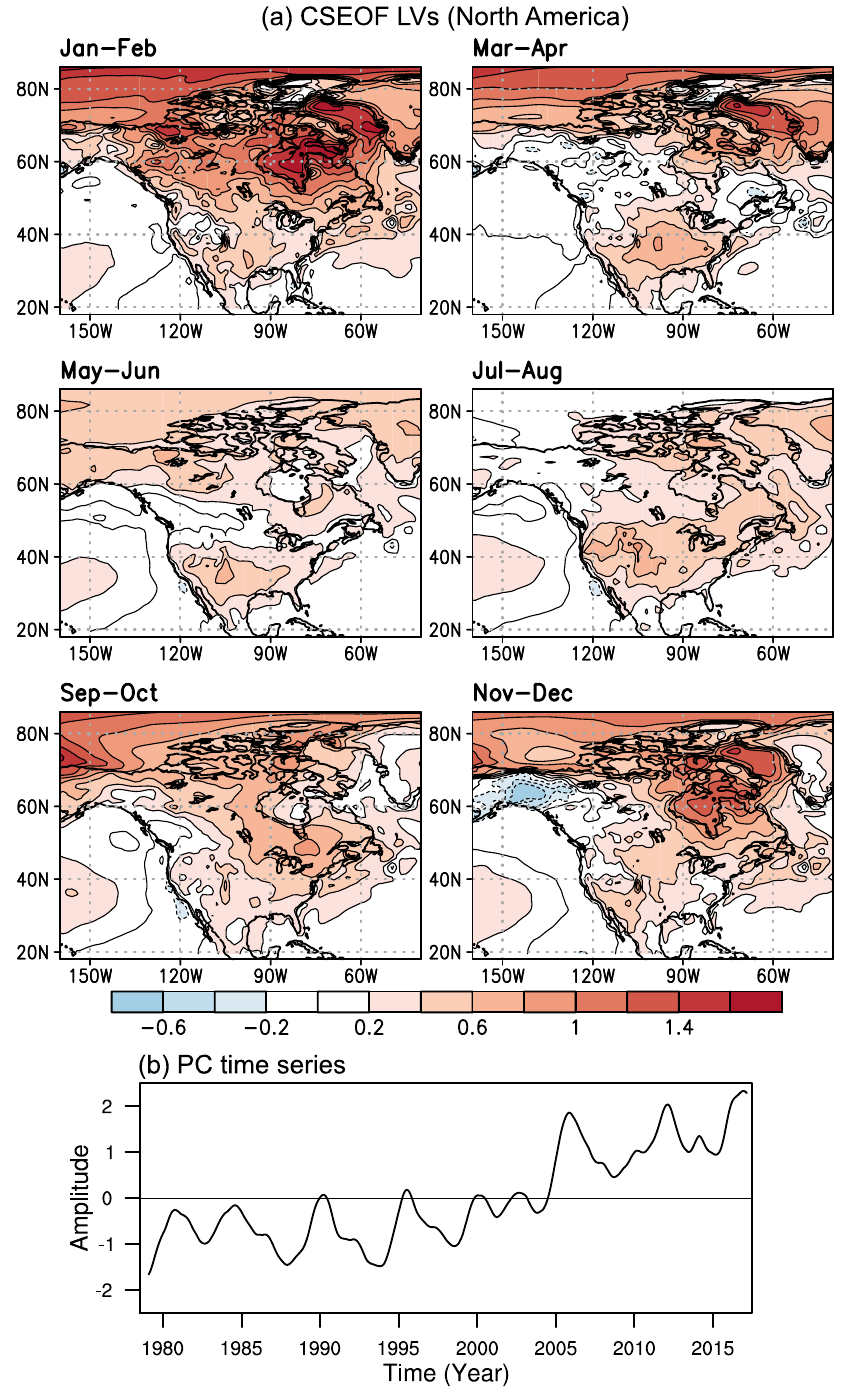
Figure 1. ( a ) The bimonthly averaged patterns of the loading vector and ( b ) the corresponding PC (principal component) time series of the first CSEOF (cyclostationary empirical orthogonal function) mode of 2 m air temperature over the Northern Hemisphere. This figure was created by using the Grid Analysis and Display System (GrADS) version 2.1 available at